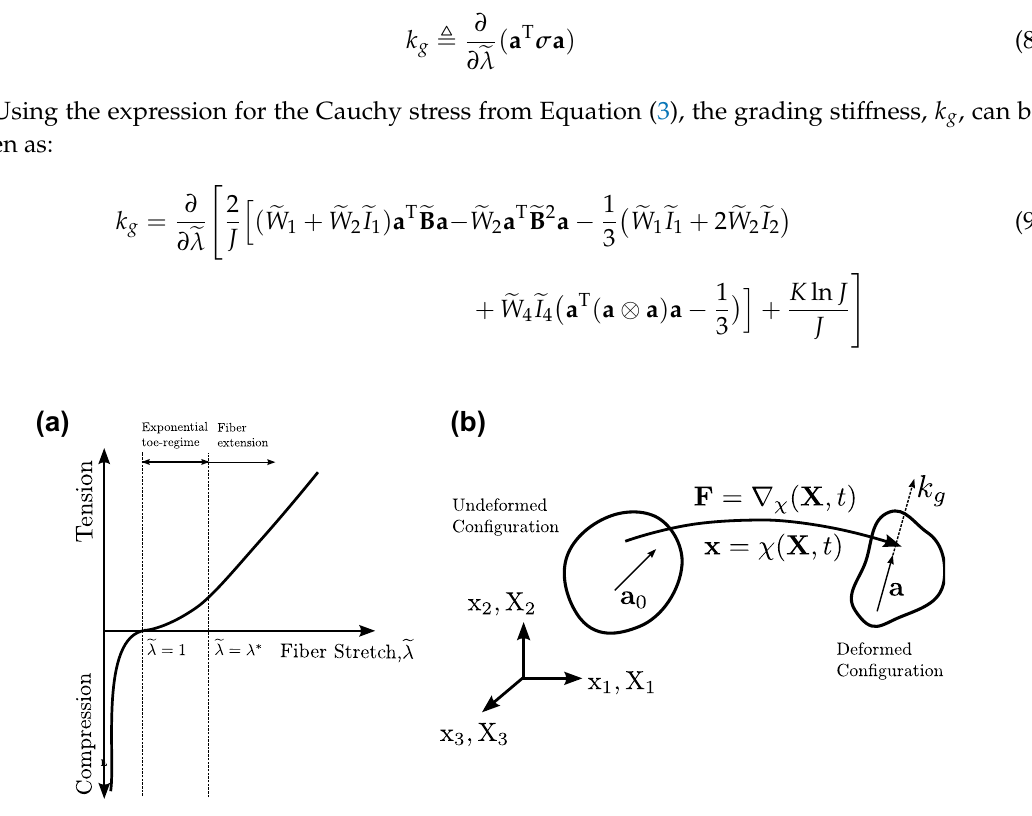
Figure 2. ( a ) Regime-dependent nature of the transversely isotropic (TI) model and ( b ) schematic of the continuum representation of the TI model